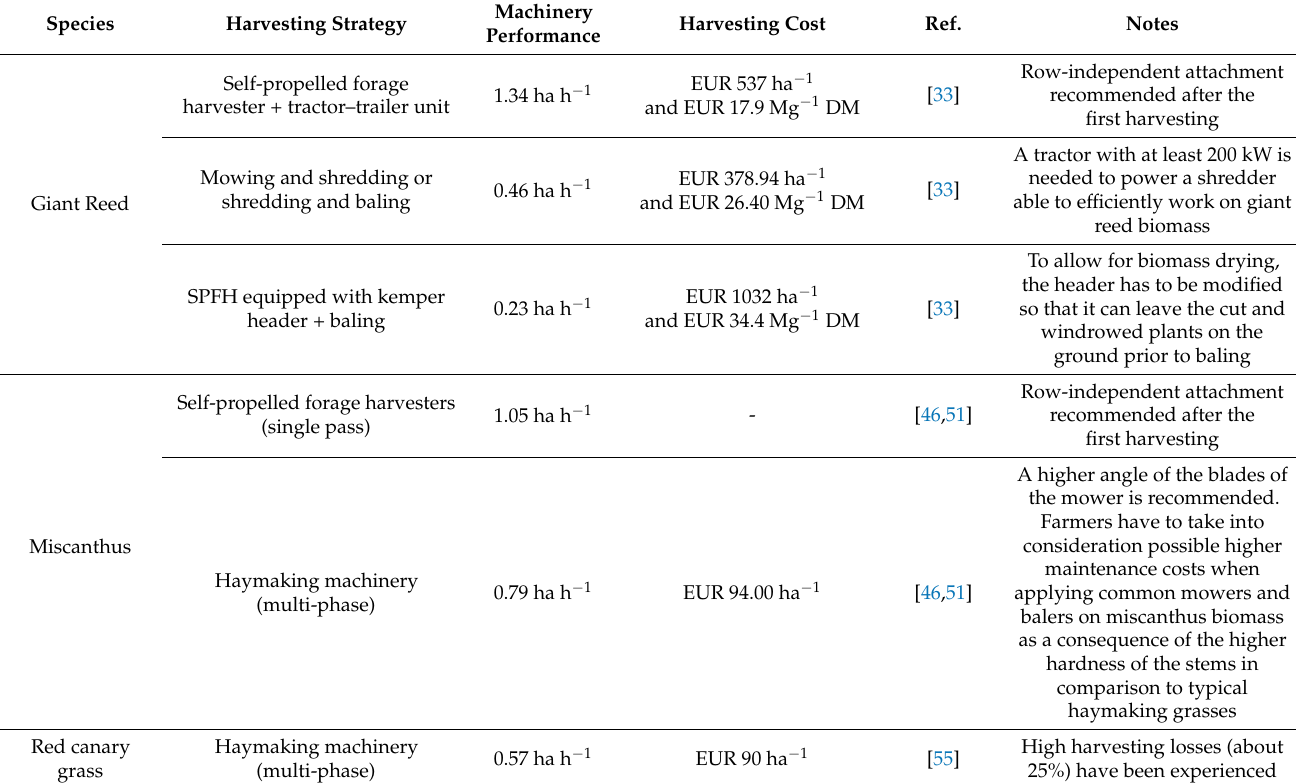
Table 1. Harvesting strategies and associated costs per